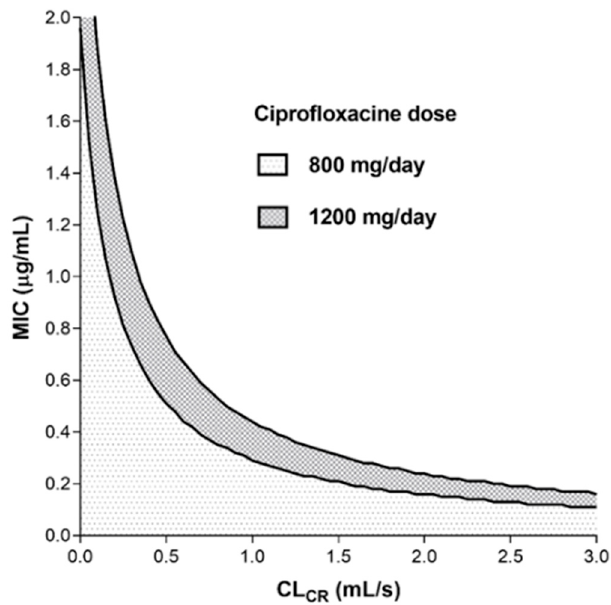
Figure 1. Nomogram representing the relation between patient creatinine clearance (CL CR ), mini- mum inhibitory concentration for the pathogen (MIC), and ciprofloxacin PK/PD target attainment (AUC 24 /MIC ratio of 125) at the usual ciprofloxacin dosage (800 or 1200 mg/day). The white area of the graph corresponds to renal clearance and MIC values, for which the standard dosing could not achieve the PK/PD target.